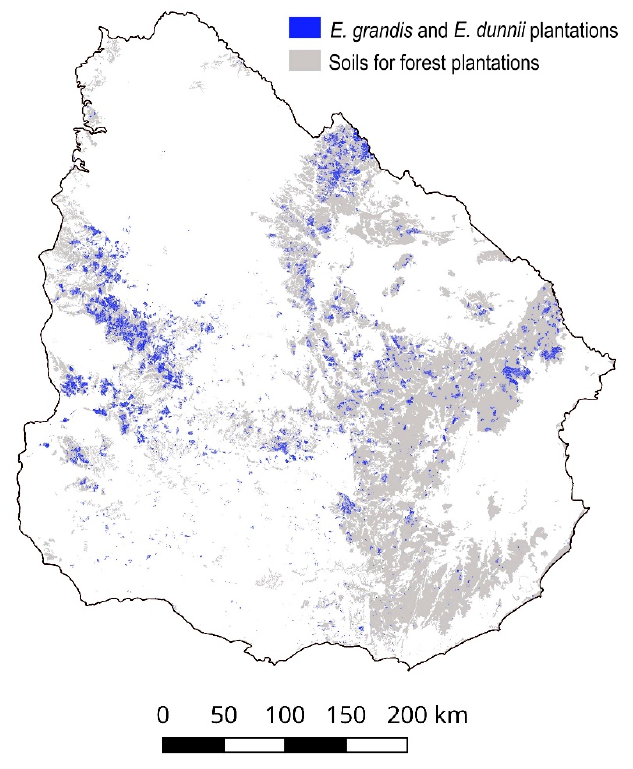
Figure 1. Map of current plantations of Eucalyptus dunnii and E. grandis. Source: http://web.renare.gub.uy/js/visores/coneat/, https://web.snig.gub.uy/arcgisprtal/apps/webappviewer/index.html?id=b90f805255ae4ef0983c2bfb40be627f.